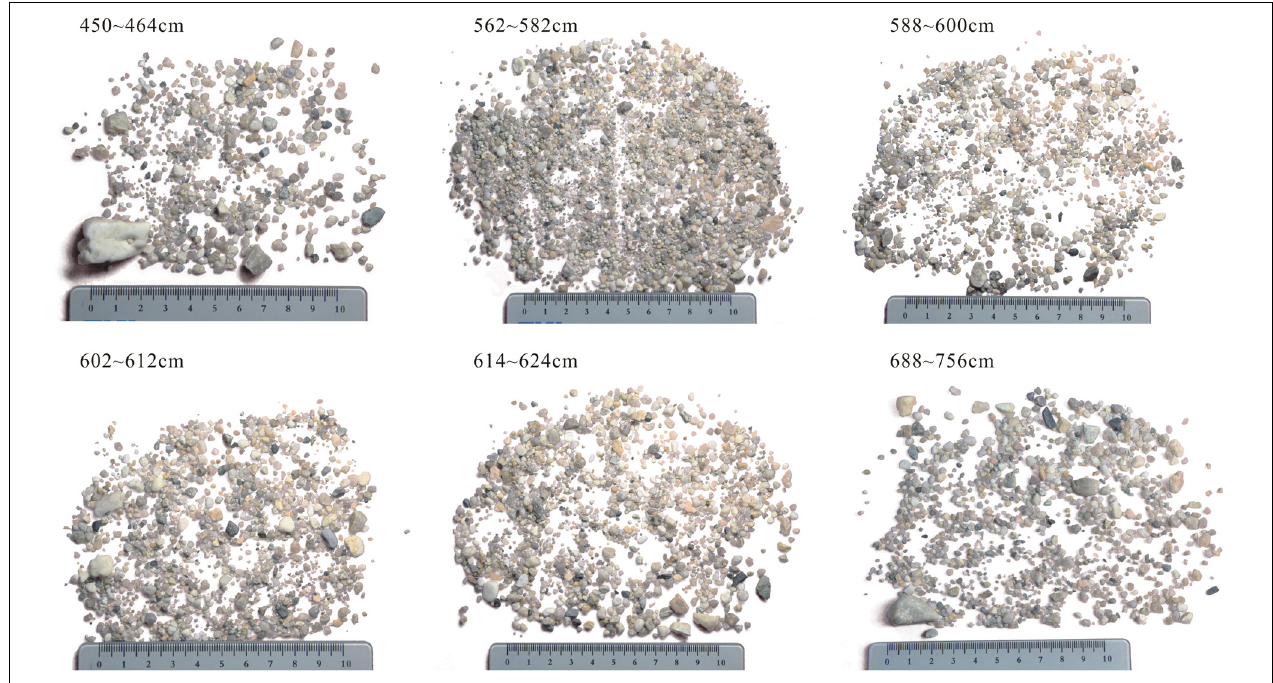
FIGURE 3 | Gravels in the Tengger Nuur lake sediments at depth of 450–756 cm, removed particle parts less than 63 µ m size.